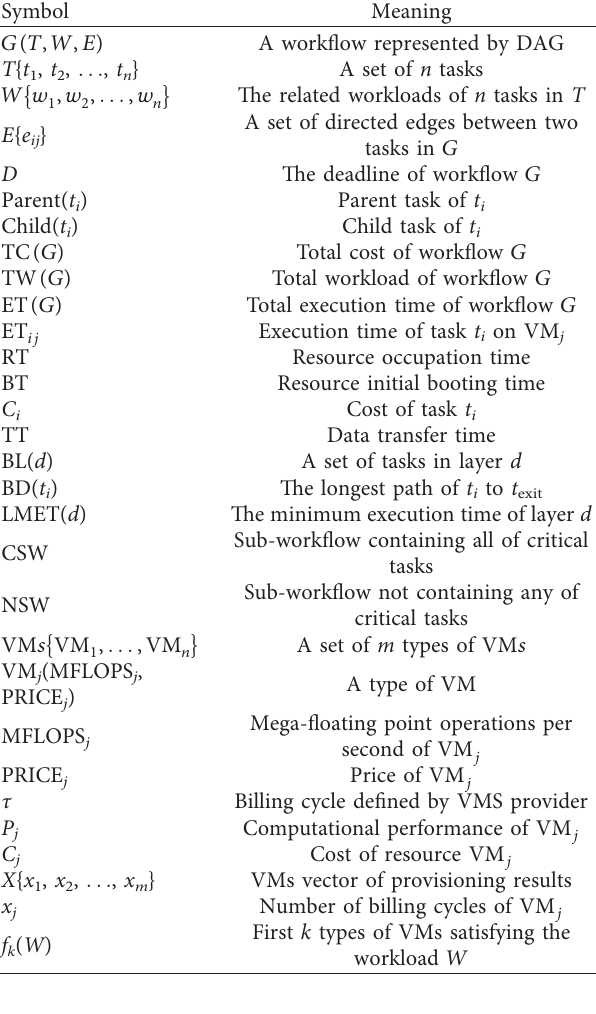
Table 1: List of symbols.